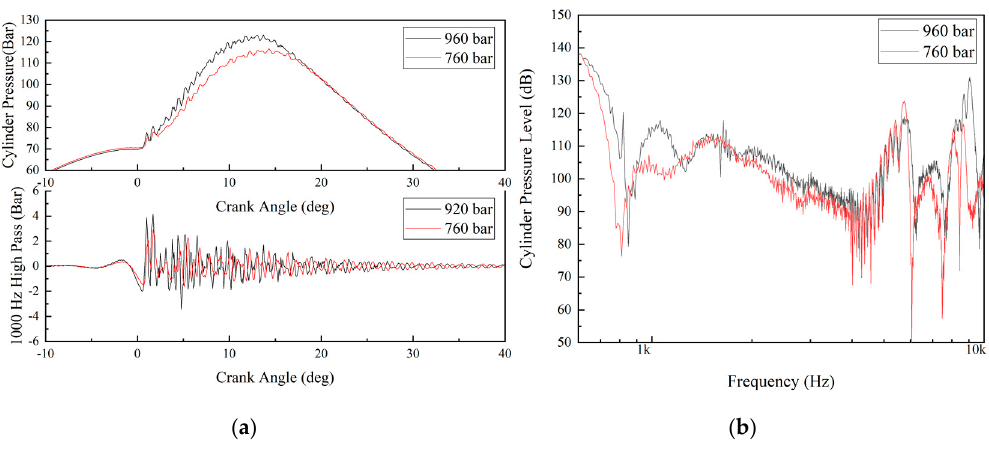
Figure 21. Cylinder pressure in ( a ) angle domain and ( b ) frequency domain of different rail pressures.